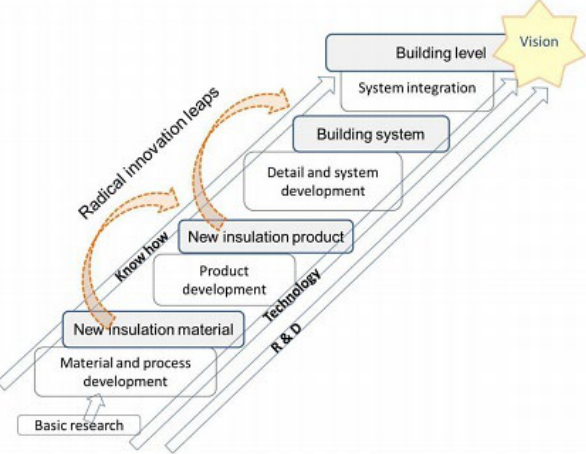
Fig. 1. Product development stages from materials to the level of energy efficient building